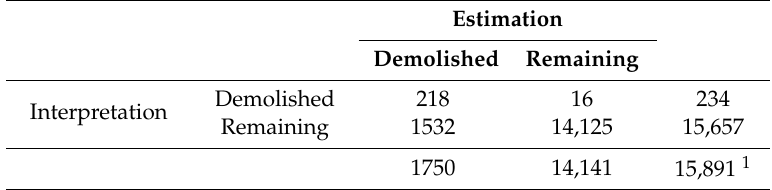
Table 6. Confusion matrix by the indicator and threshold of 0.3 for 29 July 2016 image.